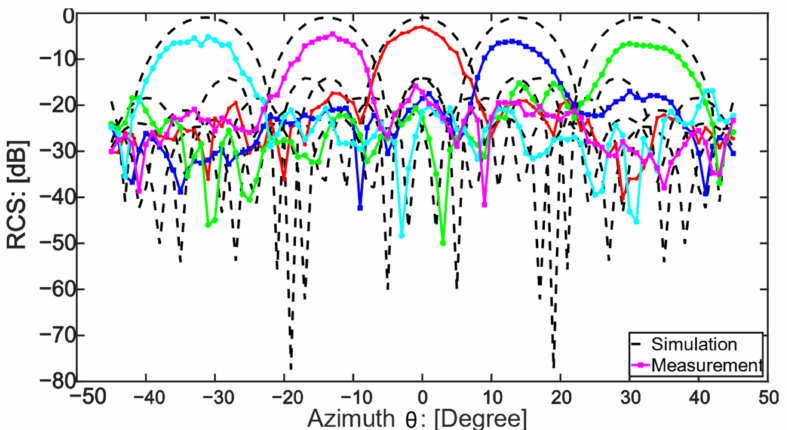
Figure 7. Far-field measurement and simulation results for several steering beams at 28.5 GHz. They show a good degree of agreement with each other. The direction of the reflect single beam is − 33 ◦ (light blue line), − 13 ◦ (pink line), 0 ◦ (red line), 13 ◦ (blue line) and 33 ◦ (green line).